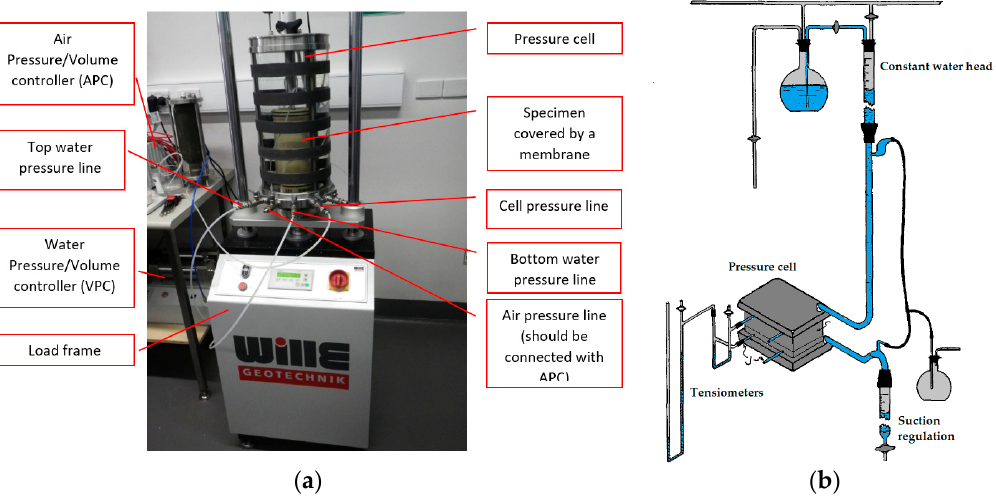
Figure 6. k unsat measurement: ( a ) unsaturated soil triaxial; ( b ) constant head method [6].